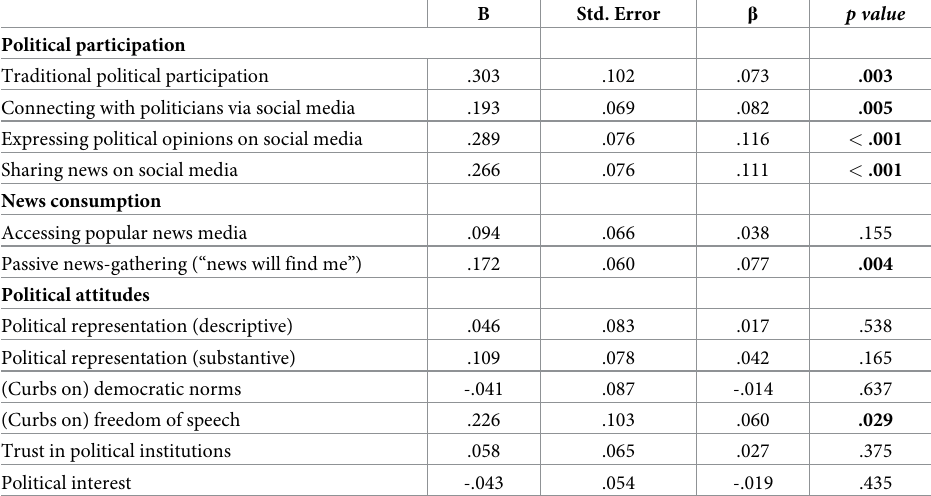
Table 4. Multilevel